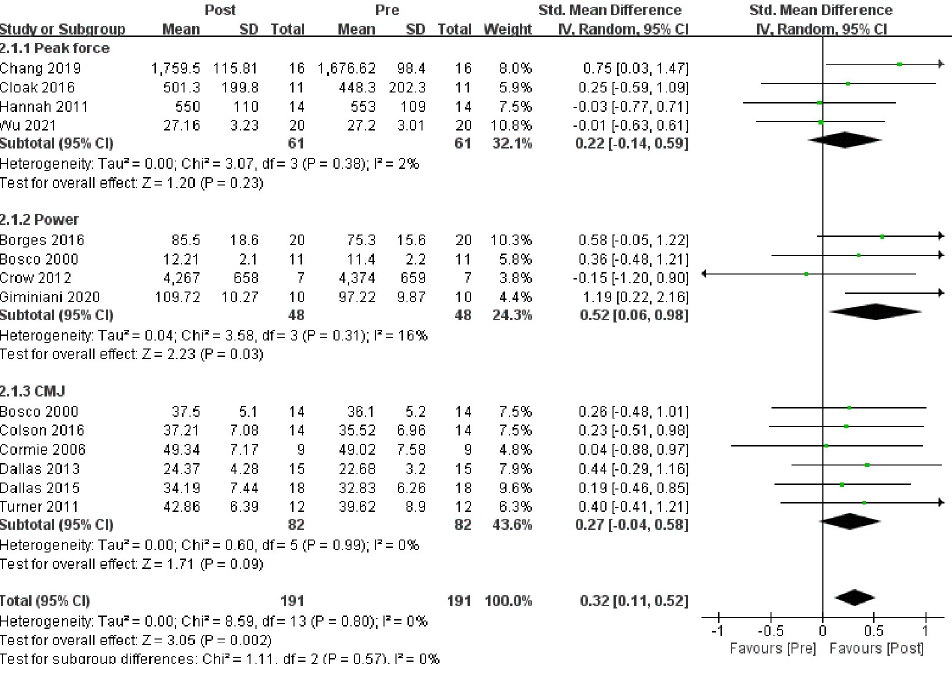
Fig 5. Meta-analysis of the acute effects of WBV on explosive